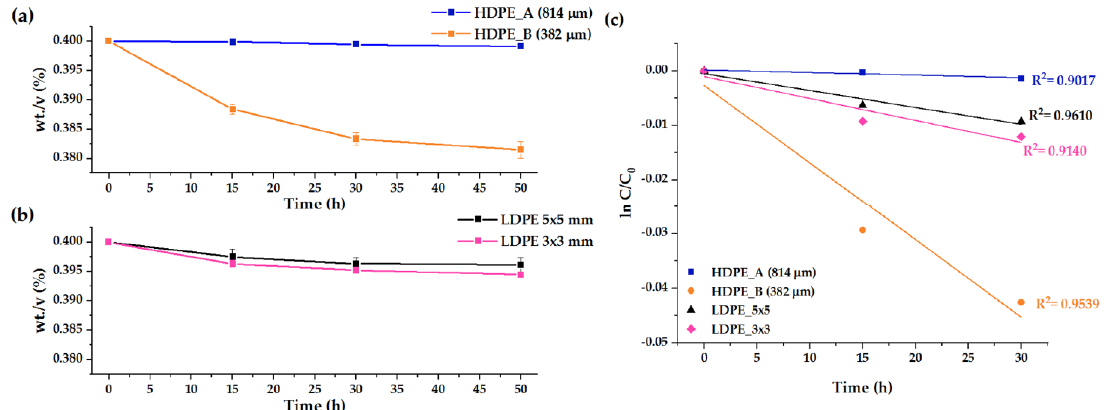
Figure 9. Degradation plots for ( a ) HDPE and ( b ) LDPE microplastics after photocatalysis at pH 3 under visible irradiation for 50 h. ( c ) Rate calculation.